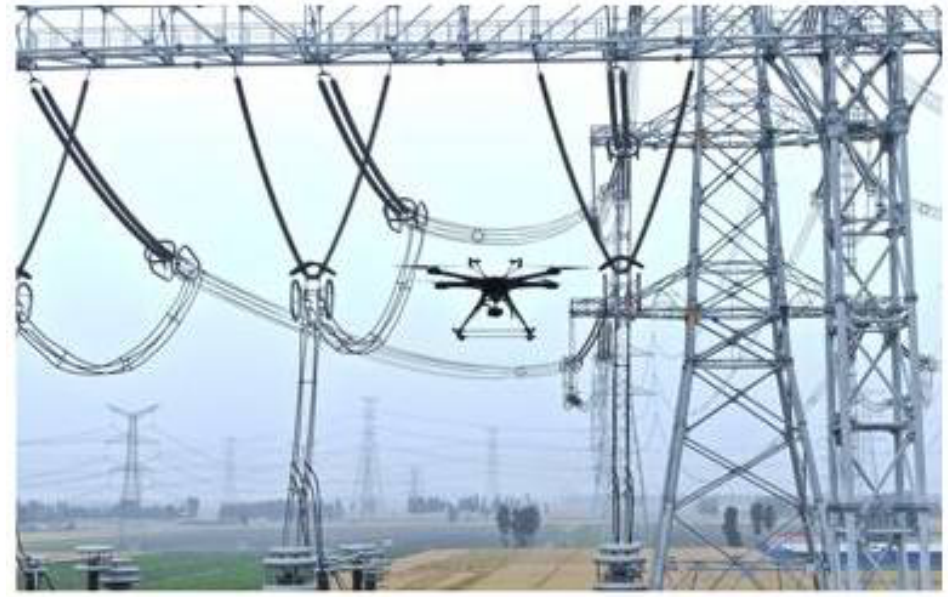
Figure 2. UAV patrol high voltage power transmission system.